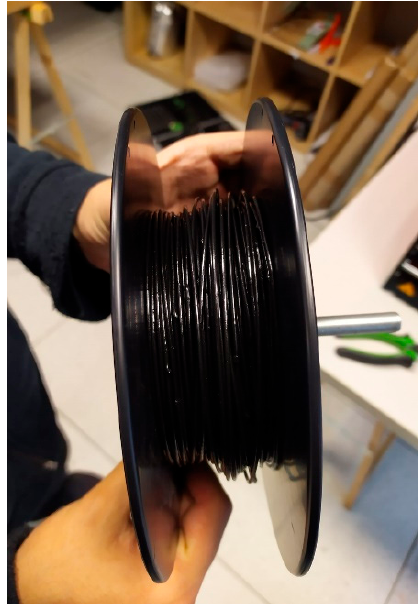
Figure 6. Recycled PLA Filament.